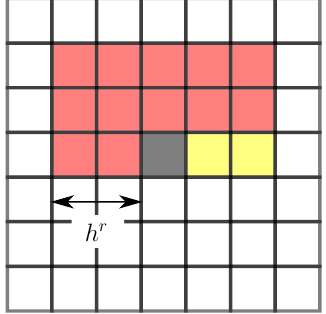
Figure 1. Illustration of the causal neighbourhood with h r = 2 pixels around the central pixel highlighted in dark grey. The red pixels represent the input data for the ANN trained in Step 1; however, in order to extract an input structure of a rectangular shape, the black and yellow pixels are also included in the inputs but their values are discarded and replaced by random binary